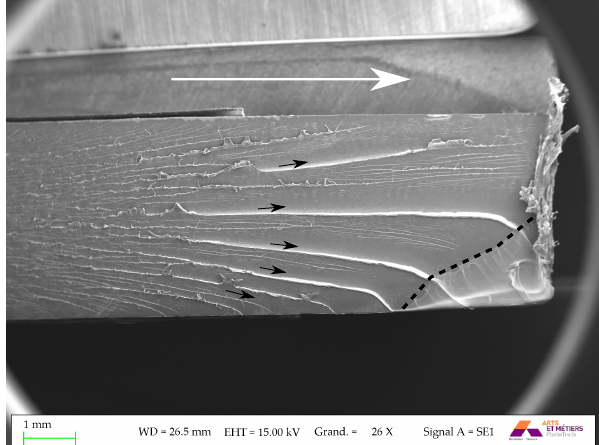
Figure 8. Observation by electron microscopy of the arrest zone of a crack on the fracture surface of sample B7. The large white arrow at the top indicates the main direction of propagation of the macrocrack front. The five small black arrows indicate the directions of propagation of several micro- cracks. The dashed line indicates the arrest zone of the crack. To the right of the specimen is an area where the material has been plastically deformed as a result of cutting the